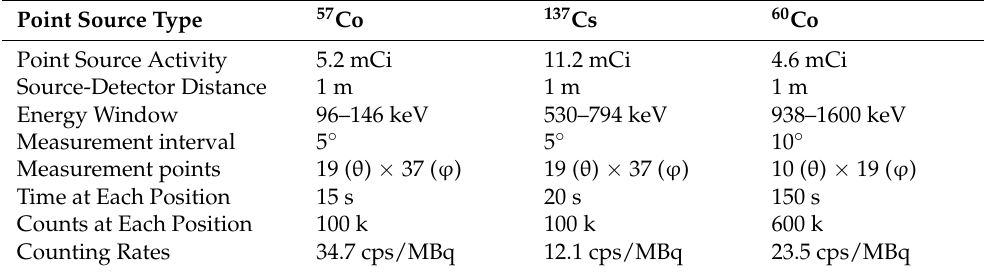
Table 1. Experimental setup.